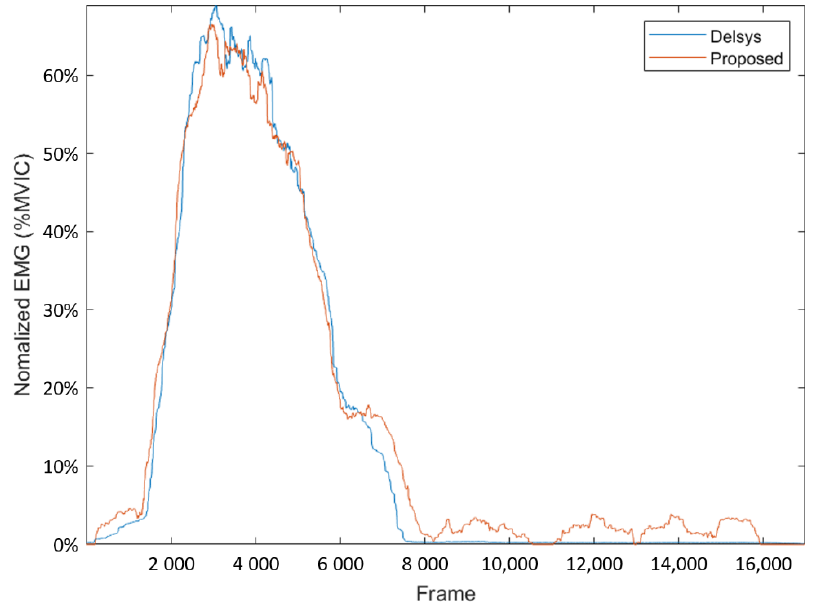
Figure 15. EMG signals from the commercial (blue) and the proposed device (orange).